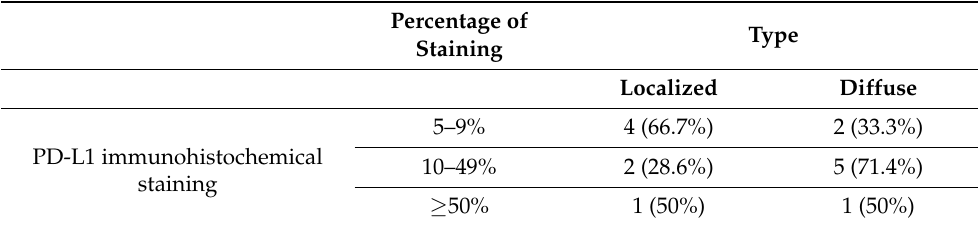
Chi-square test: p =